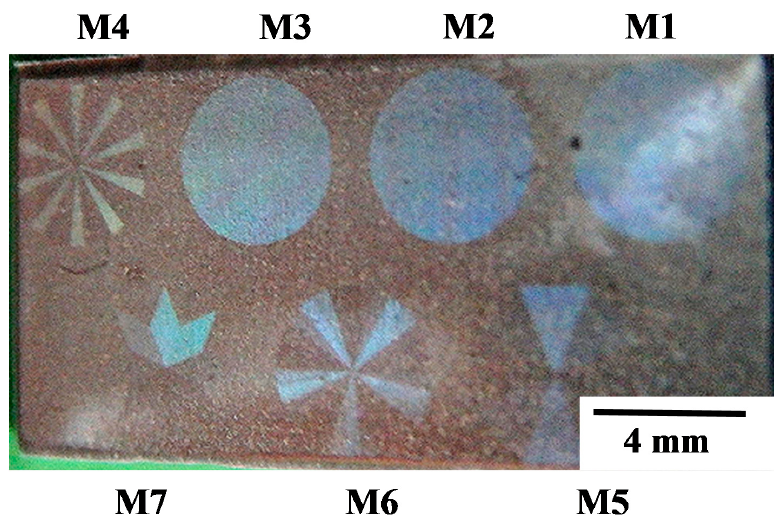
Figure 7. Pure aluminum plate with coined seven microtextures, each of which has nanotextured segments. Each microtexture M1 – M7 in the above just corresponds to the original one from M1 to M7 in Figure 4.